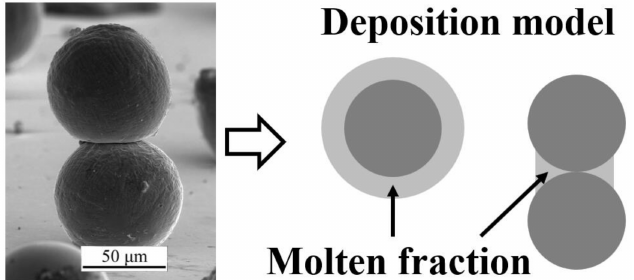
Figure 2. Schematic of deposition